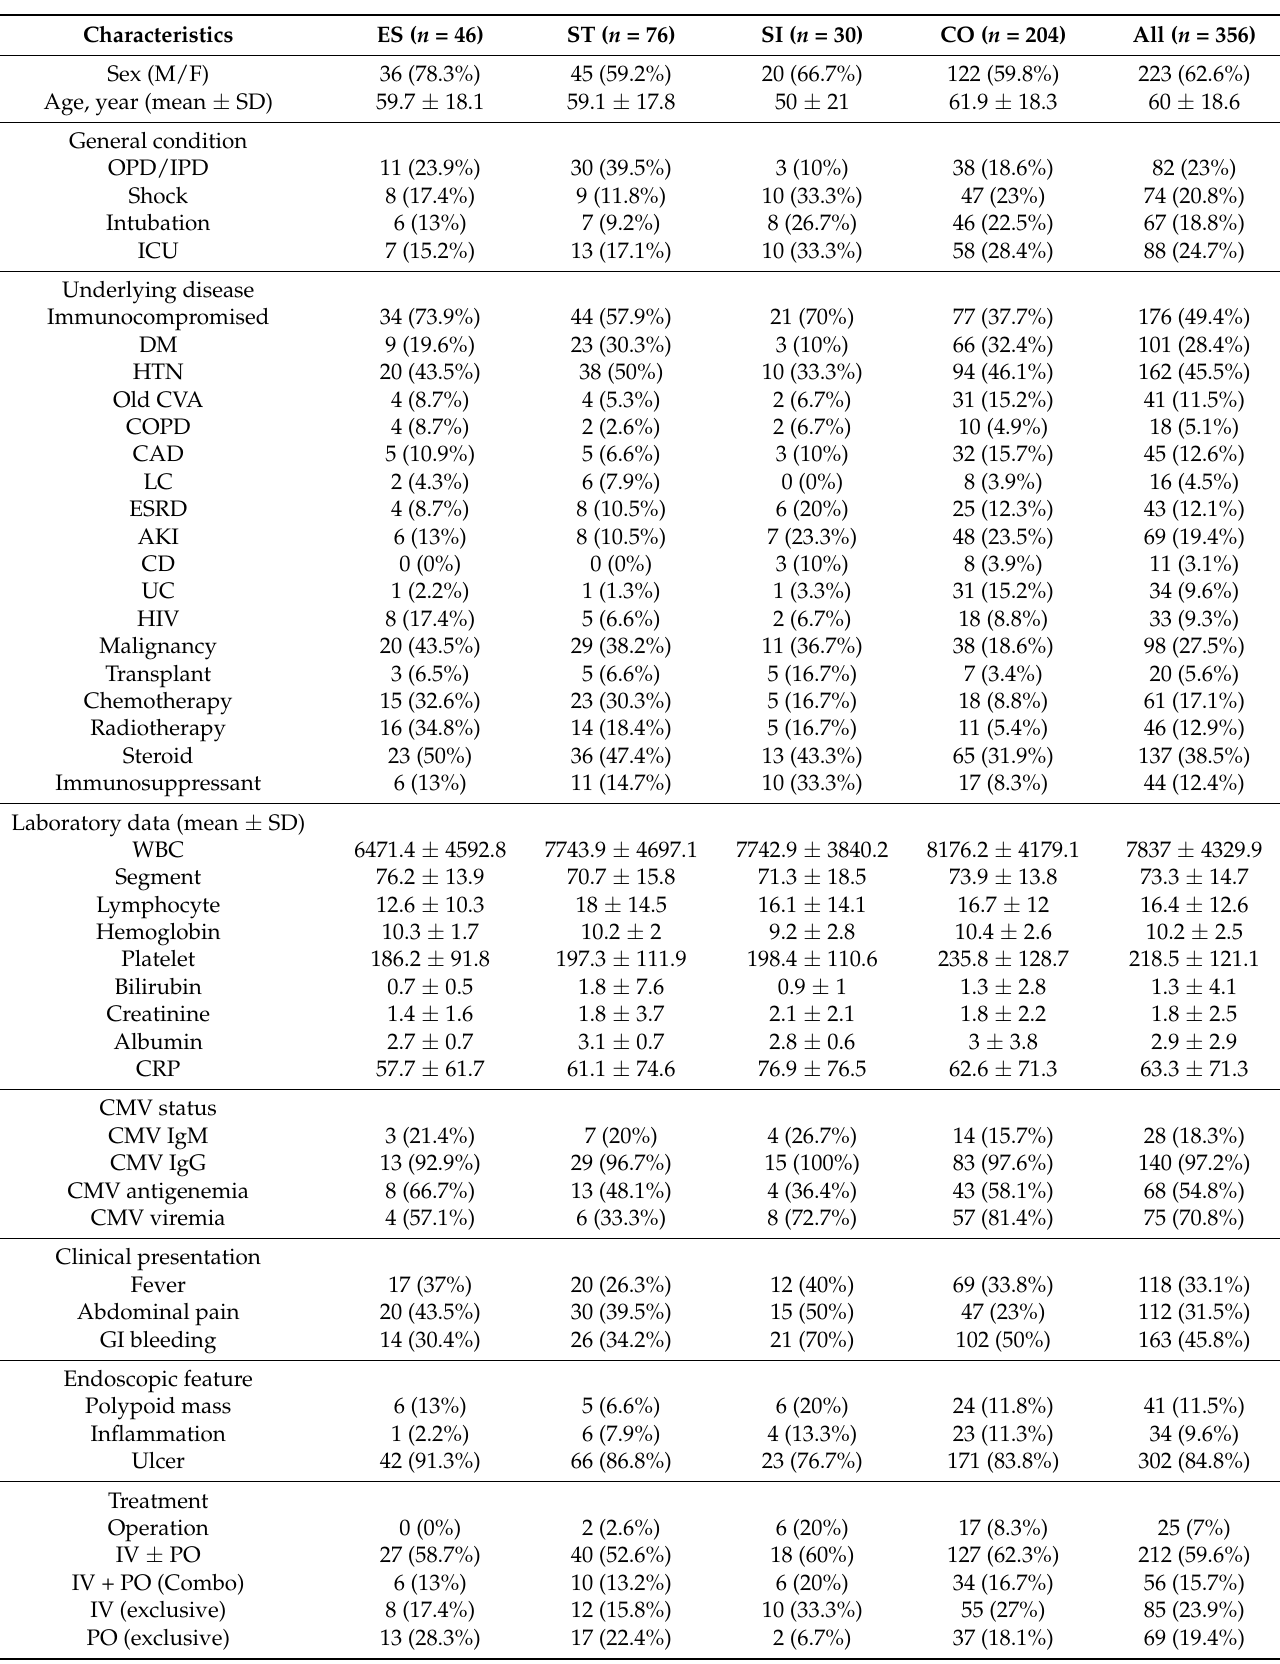
Table 1. Characteristics of different segments of CMV GI